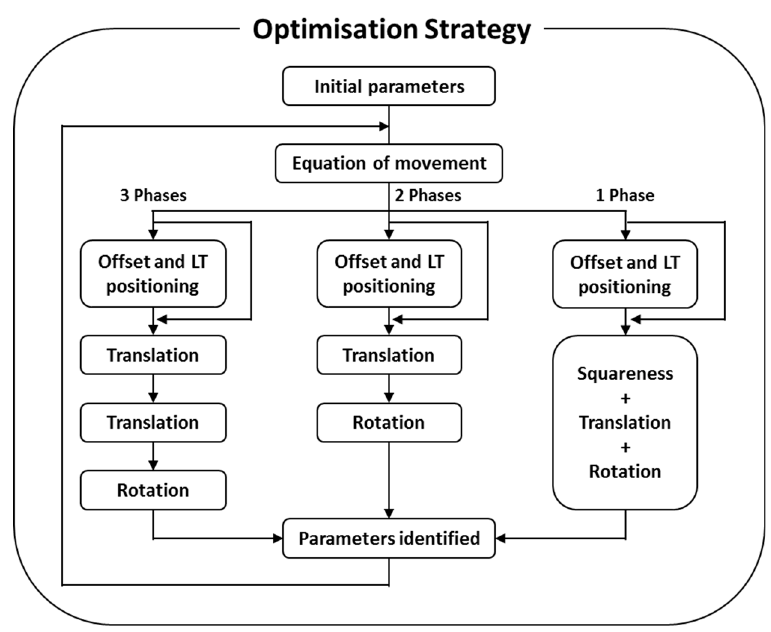
Figure 6. Optimization strategy scheme.